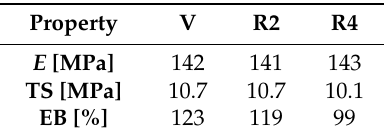
Table 1. Elastic modulus ( E ), tensile strength (TS), elongation at break (EB) for pristine (V) and reprocessed (two times: R2, four times: R4) BioFlex.